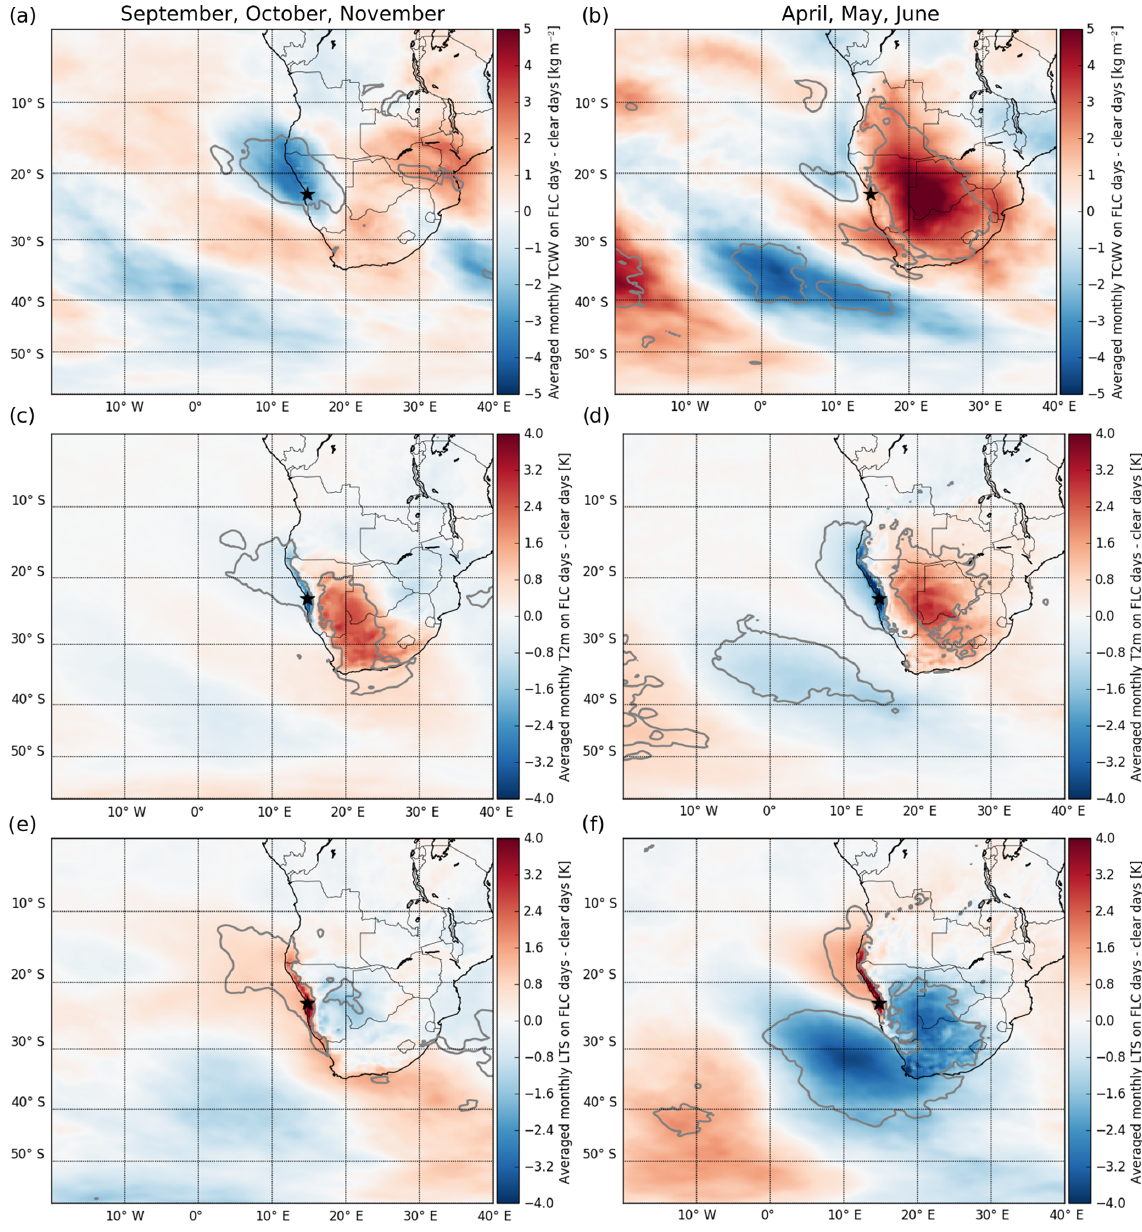
Figure 5. Mean of monthly average differences (FLC days − clear days) during (a, c, e) SON and (b, d, f) AMJ of (a, b) TCWV, (c, d) T2m, and (e, f) LTS for the time period 2004–2017. Contours mark significant differences as in Fig.